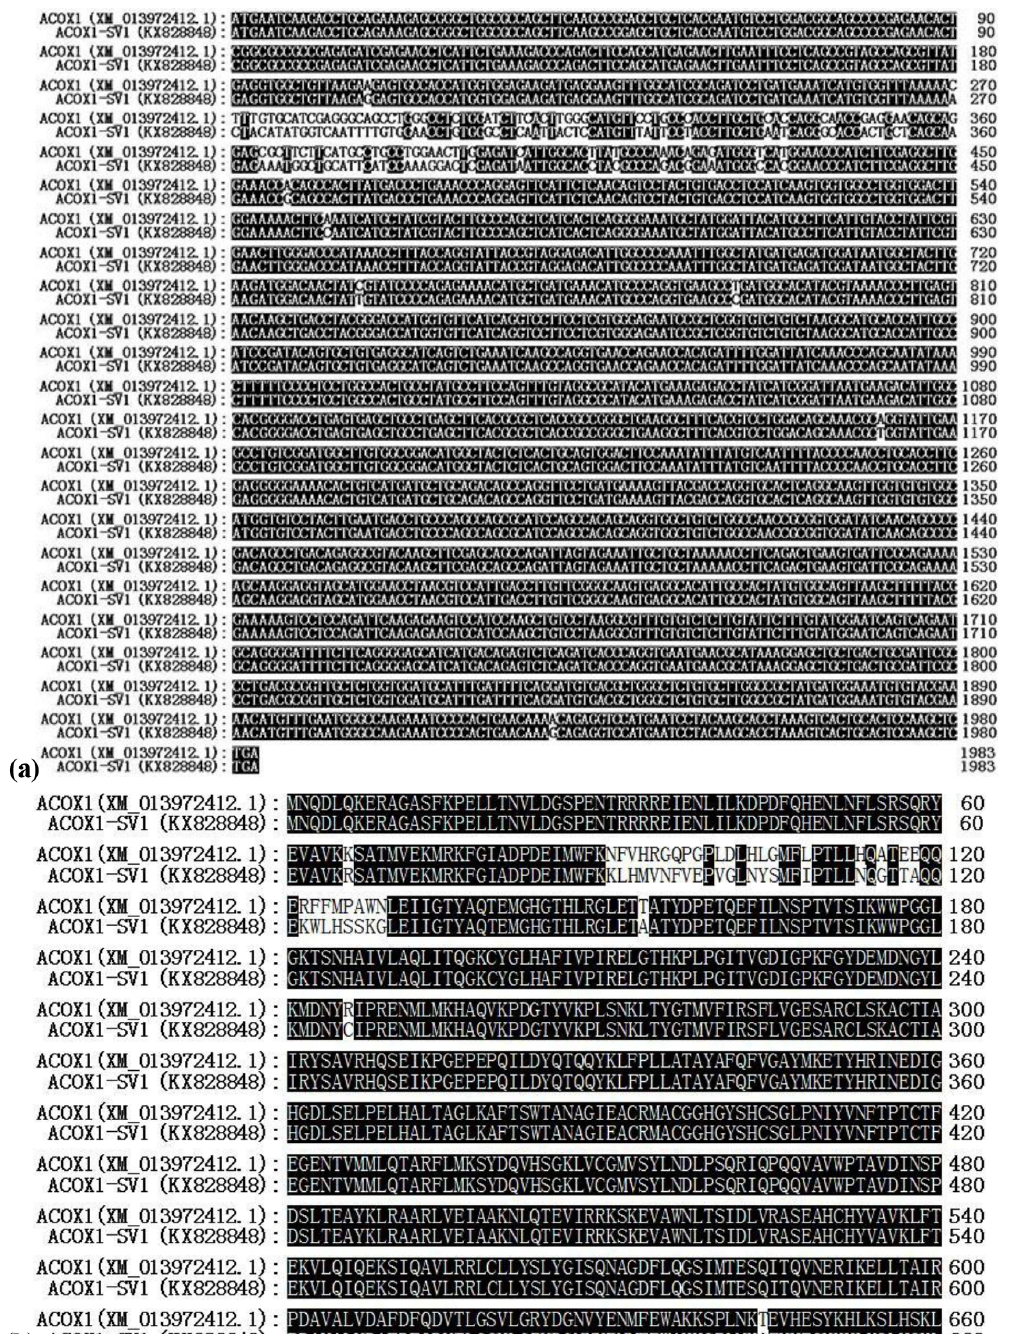
Figure 2. Alignment of nucleotide (a) and protein sequences (b) of ACOX1 and ACOX1-SV1 variants.